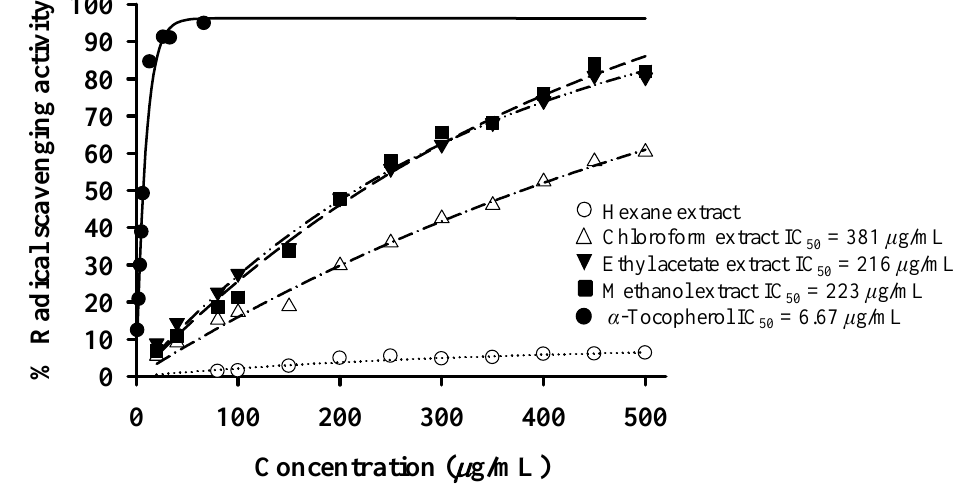
Figure 11. Superoxide dismutase activity of crude